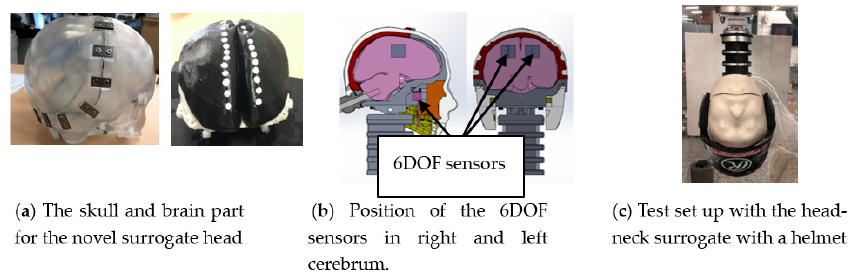
Figure 1. Novel human head